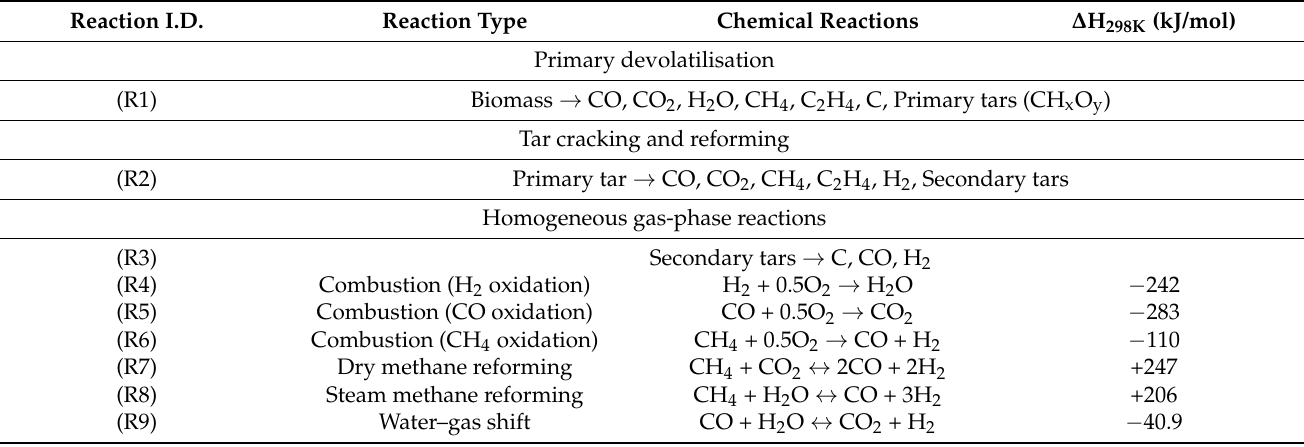
Table 3. Main chemical reactions during biomass steam gasification [3]. Reaction